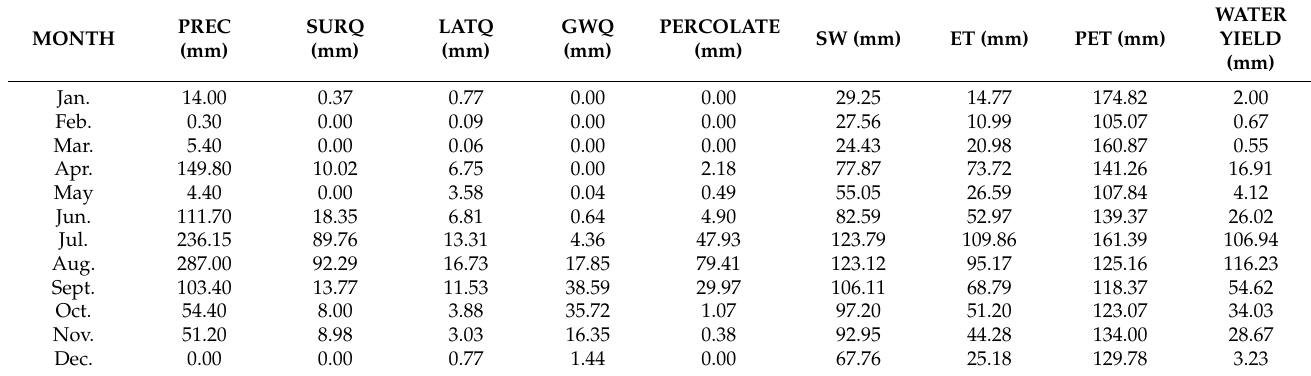
Table 6. Average long-term (1979–2017) monthly water balance estimates of the SWAT–MODFLOW model in the study